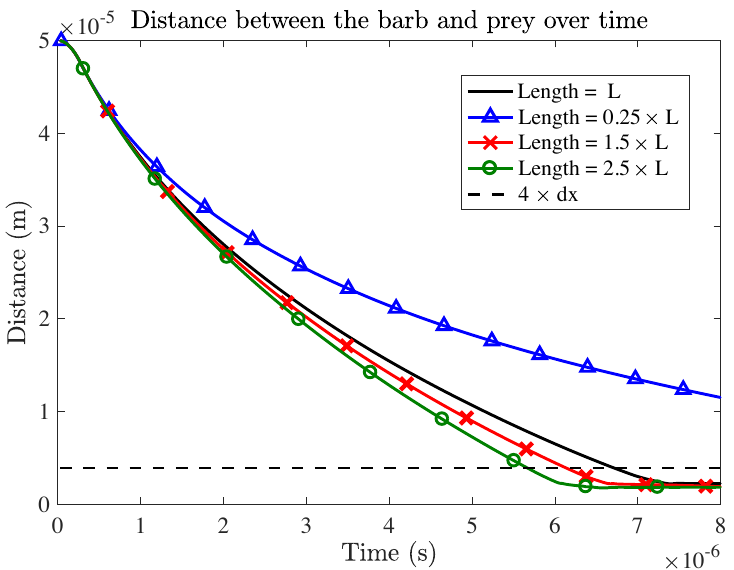
Figure 10. The distance between the top of the barb and the nearest point on the prey as a function of time for barbs of different lengths. The default length of the barb L = 5.0 × 10 − 5 m, and the length is varied to be L × 0.25, L × 1.5, and L × 2.5. The radius of the prey is the default value of R = 2.5 × 10 − 5 m, and the Re = 900. The dashed black line denotes the threshold value of 4 dx , where the value of dx is taken to be at the most refined grid